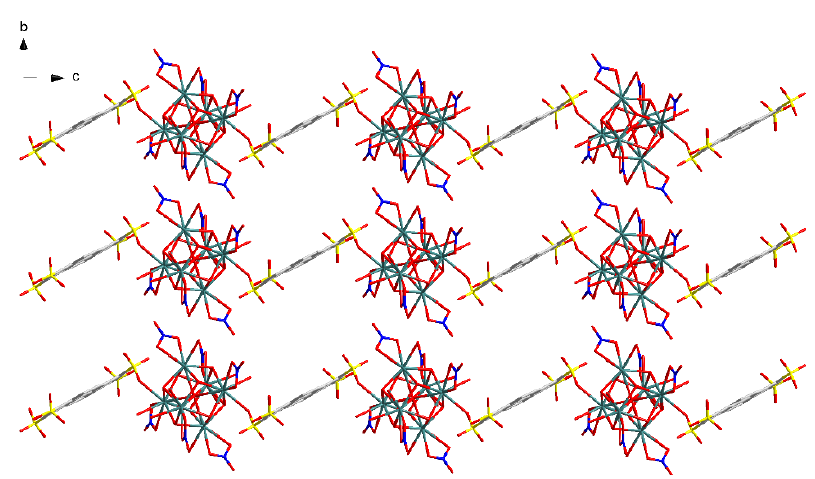
Figure 3. The packed chain-like structure in compound 1 along the a direction.